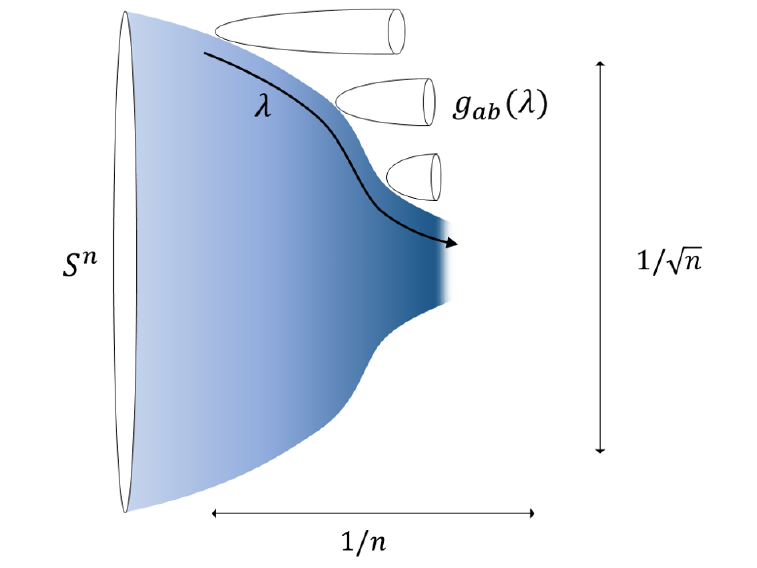
Figure 3 . Ricci (cid:13)ow of merger geometries in D = p + n + 1 dimensions, in the limit n ! 1 . The p -dimensional metric g ab ( (cid:21) ) satis(cid:12)es the Ricci (cid:13)ow equation with parameter (cid:21) , while the radius (cid:26) of p the S n factor shrinks as (cid:26) = 2( (cid:21) 0 (cid:0) (cid:21) ). In this article we discuss in detail two-dimensional (cid:13)ows in which the circular direction in (Euclidean) g ab shrinks to zero at the (Lorentzian) horizon of a black hole or black string. The (cid:13)ow starts at (cid:21) = (cid:0)1 , and depending on whether g ab collapses at (cid:21) < (cid:21) 0 , at (cid:21) = (cid:21) 0 , or does not collapse by (cid:21) = (cid:21) 0 , we get fused, critical, or split conifolds,